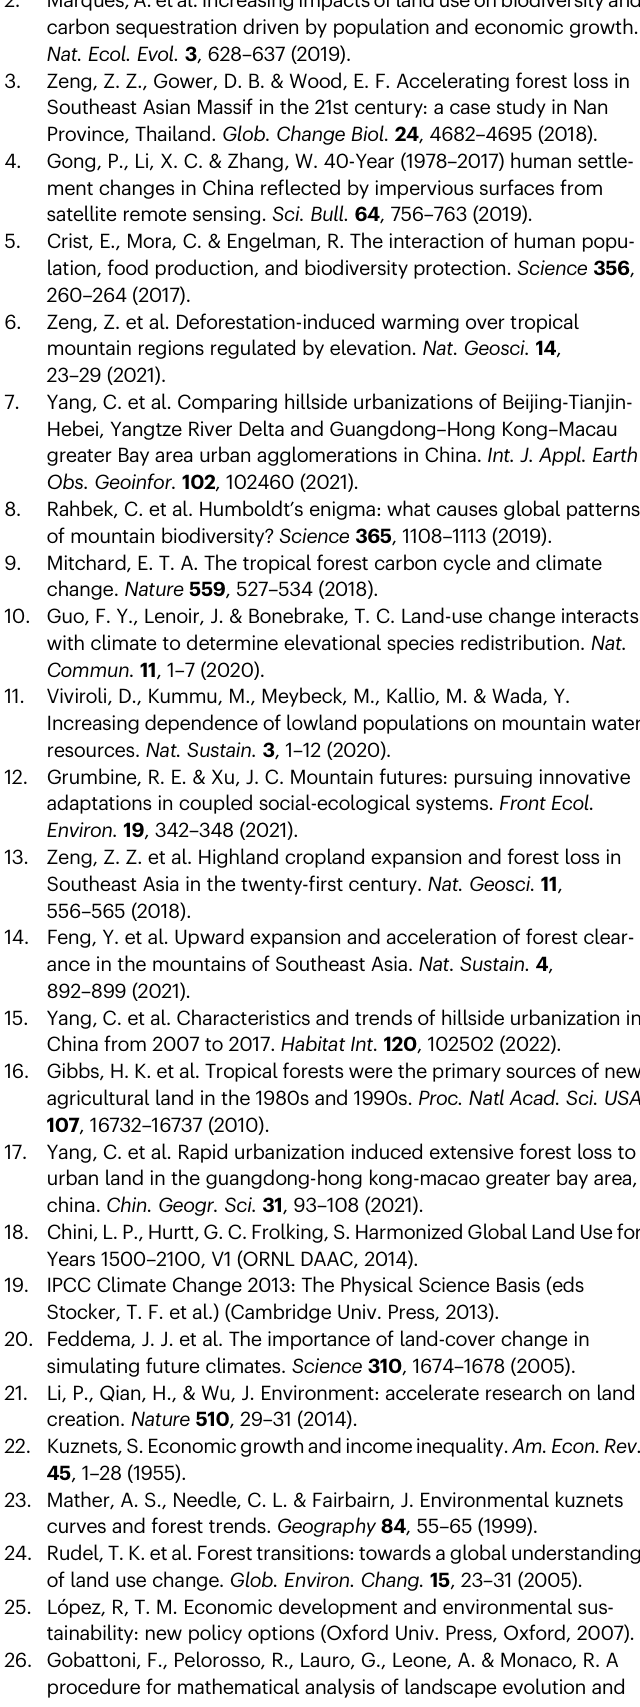
Table 1; human activity expansion-induced ecological land loss in highlands and lowlands in Supplementary Table